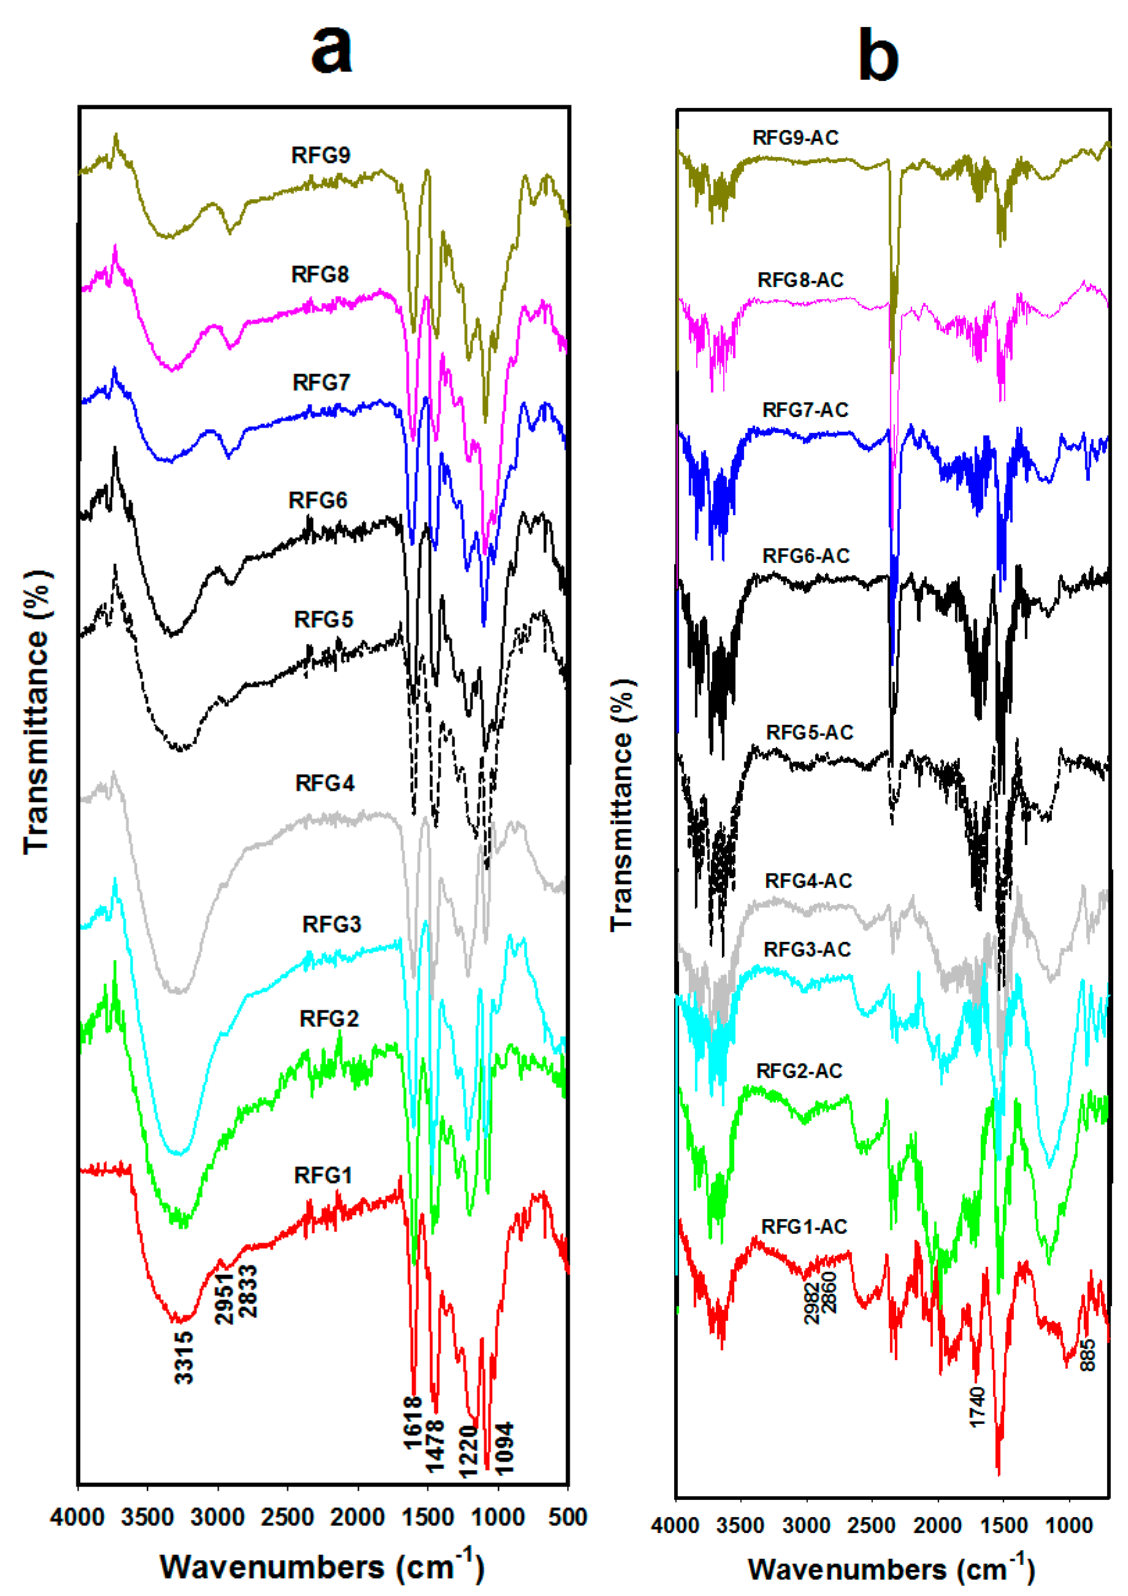
Figure 3. FTIR spectra of ( a ) RFG n samples synthesized at various molar ratios and ( b ) their corre- sponding activated carbons (RFG n -AC).